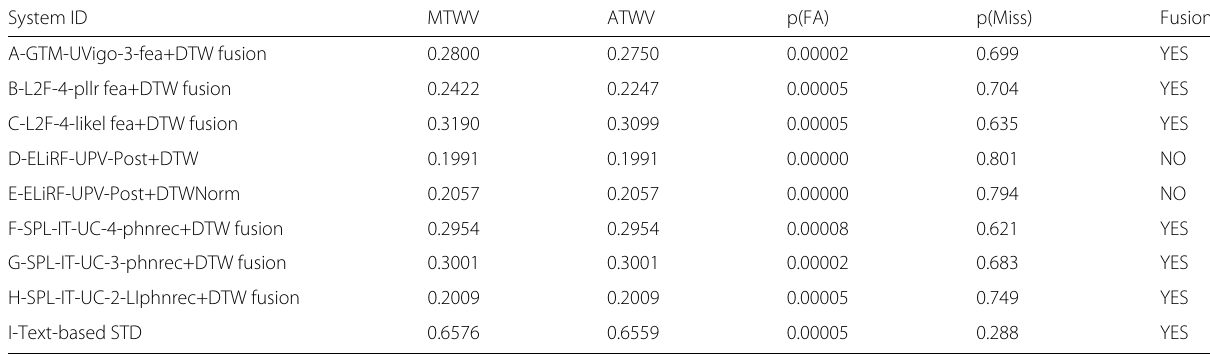
Table 9 System results of the ALBAYZIN QbE STD 2016 evaluation on the development data System